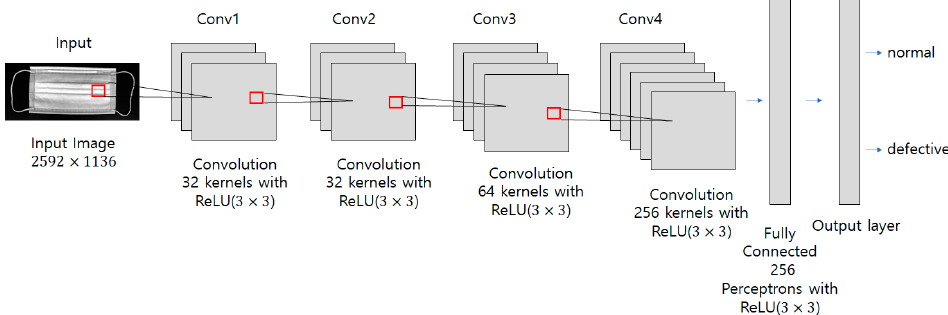
Figure 6. Nonlinear defect CNN model used in the proposed method.